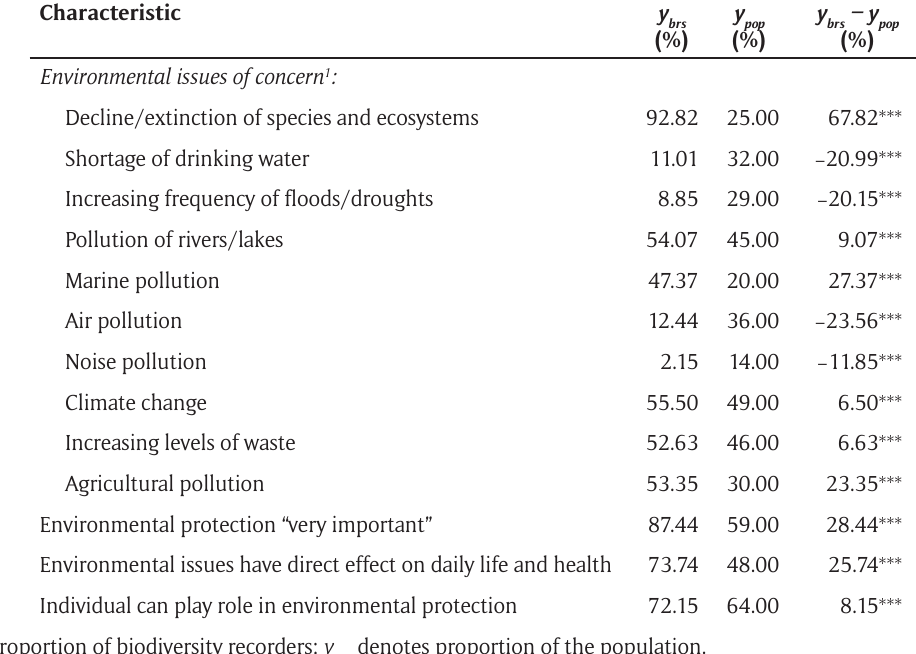
Table 6: Attitudes towards the environment in biodiversity recorders compared with those of adult population in Ireland using Special Eurobarometer